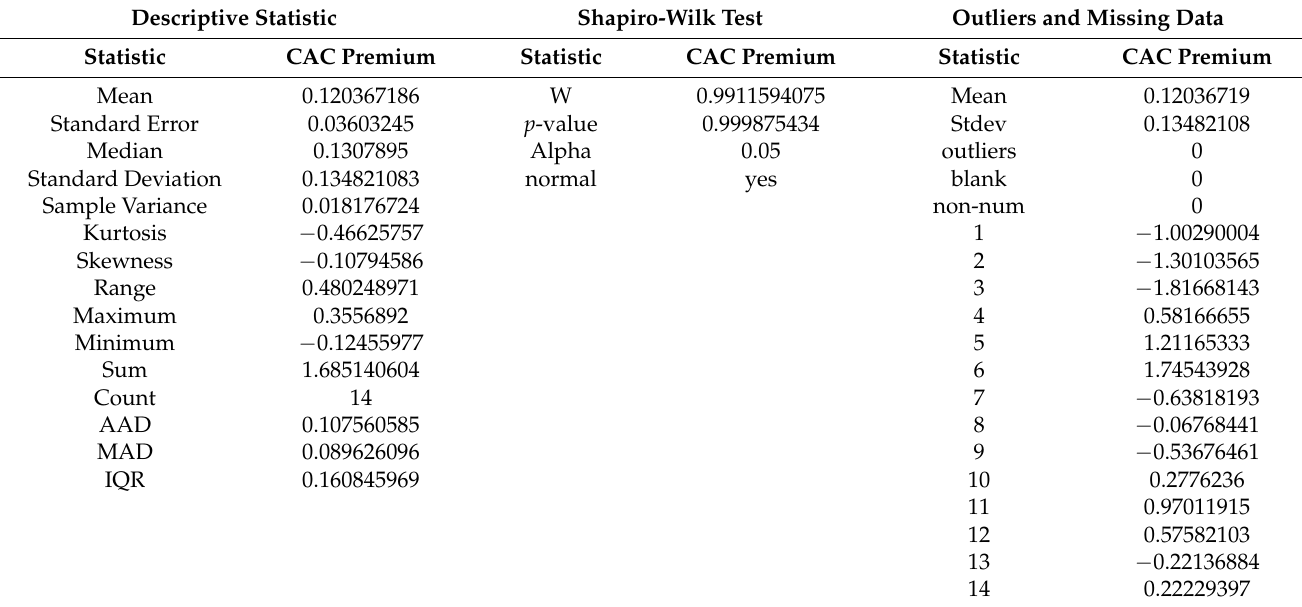
Table A5. Descriptive Statistics 10-year sovereign bond and result (Source: